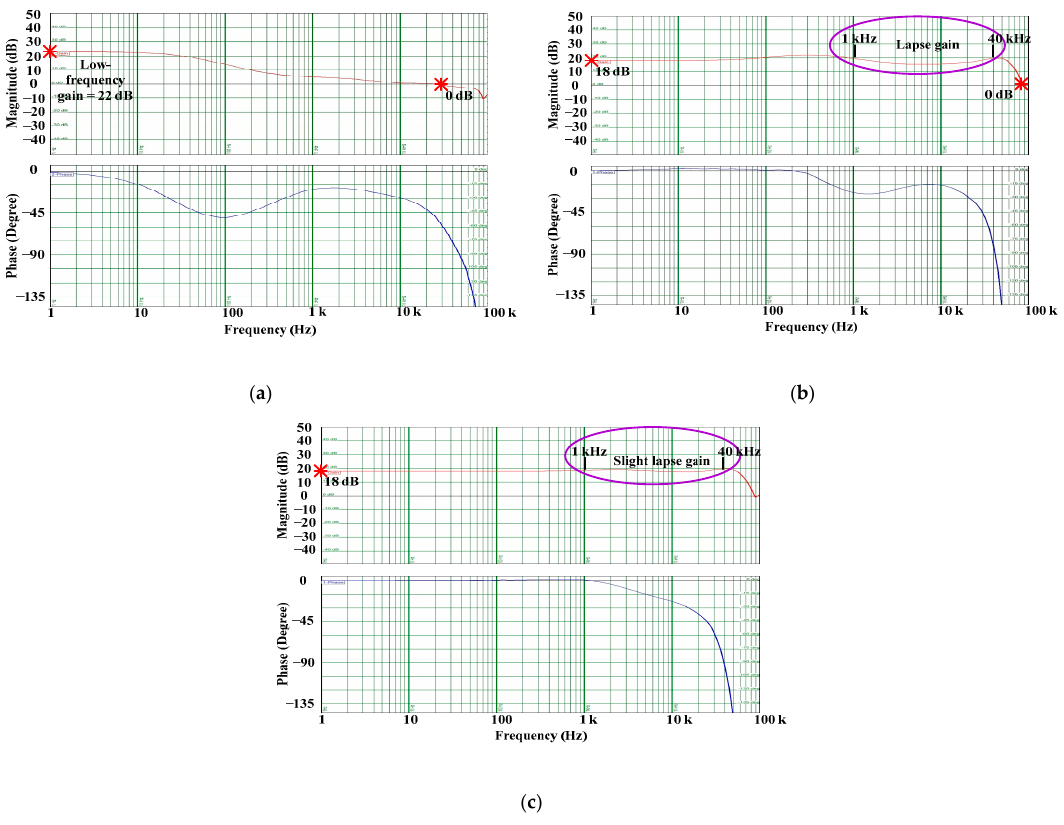
Figure 22. Bode plot measurements for G fbv and G fbc : ( a ) G fbv using PI control. ( b ) G fbc using PI control. ( c ) G fbc using the ZBFS method.